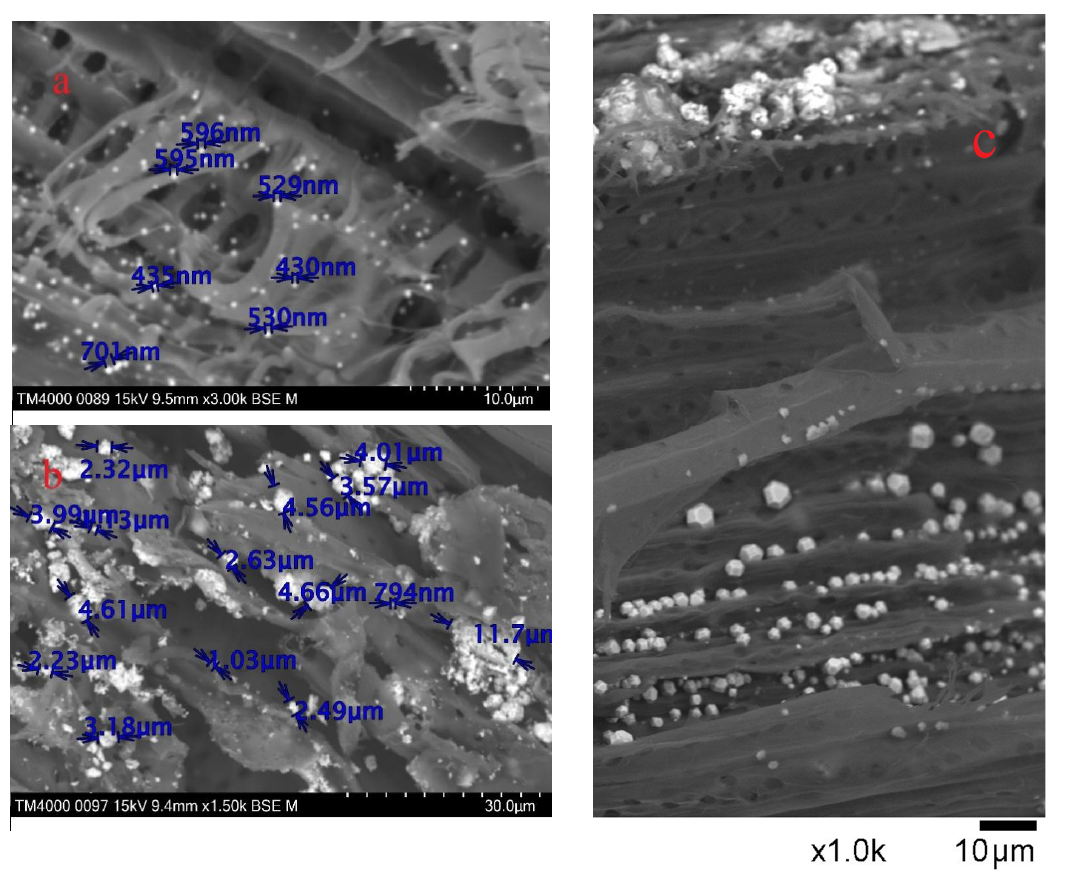
Figure 2. Distribution of catalyst particles (Cu 2 O main phase) on the outer surface of the flax shives ( left ) and on the inner slice ( right ) of the shive particles. Stirring speed of 500 rpm. Process condi- tions: raw material loading—50 g/L, copper oxide—12 g/L, oxygen partial pressure 0.2 MPa, stirring speed–500 rpm, reaction mass volume—300 mL.